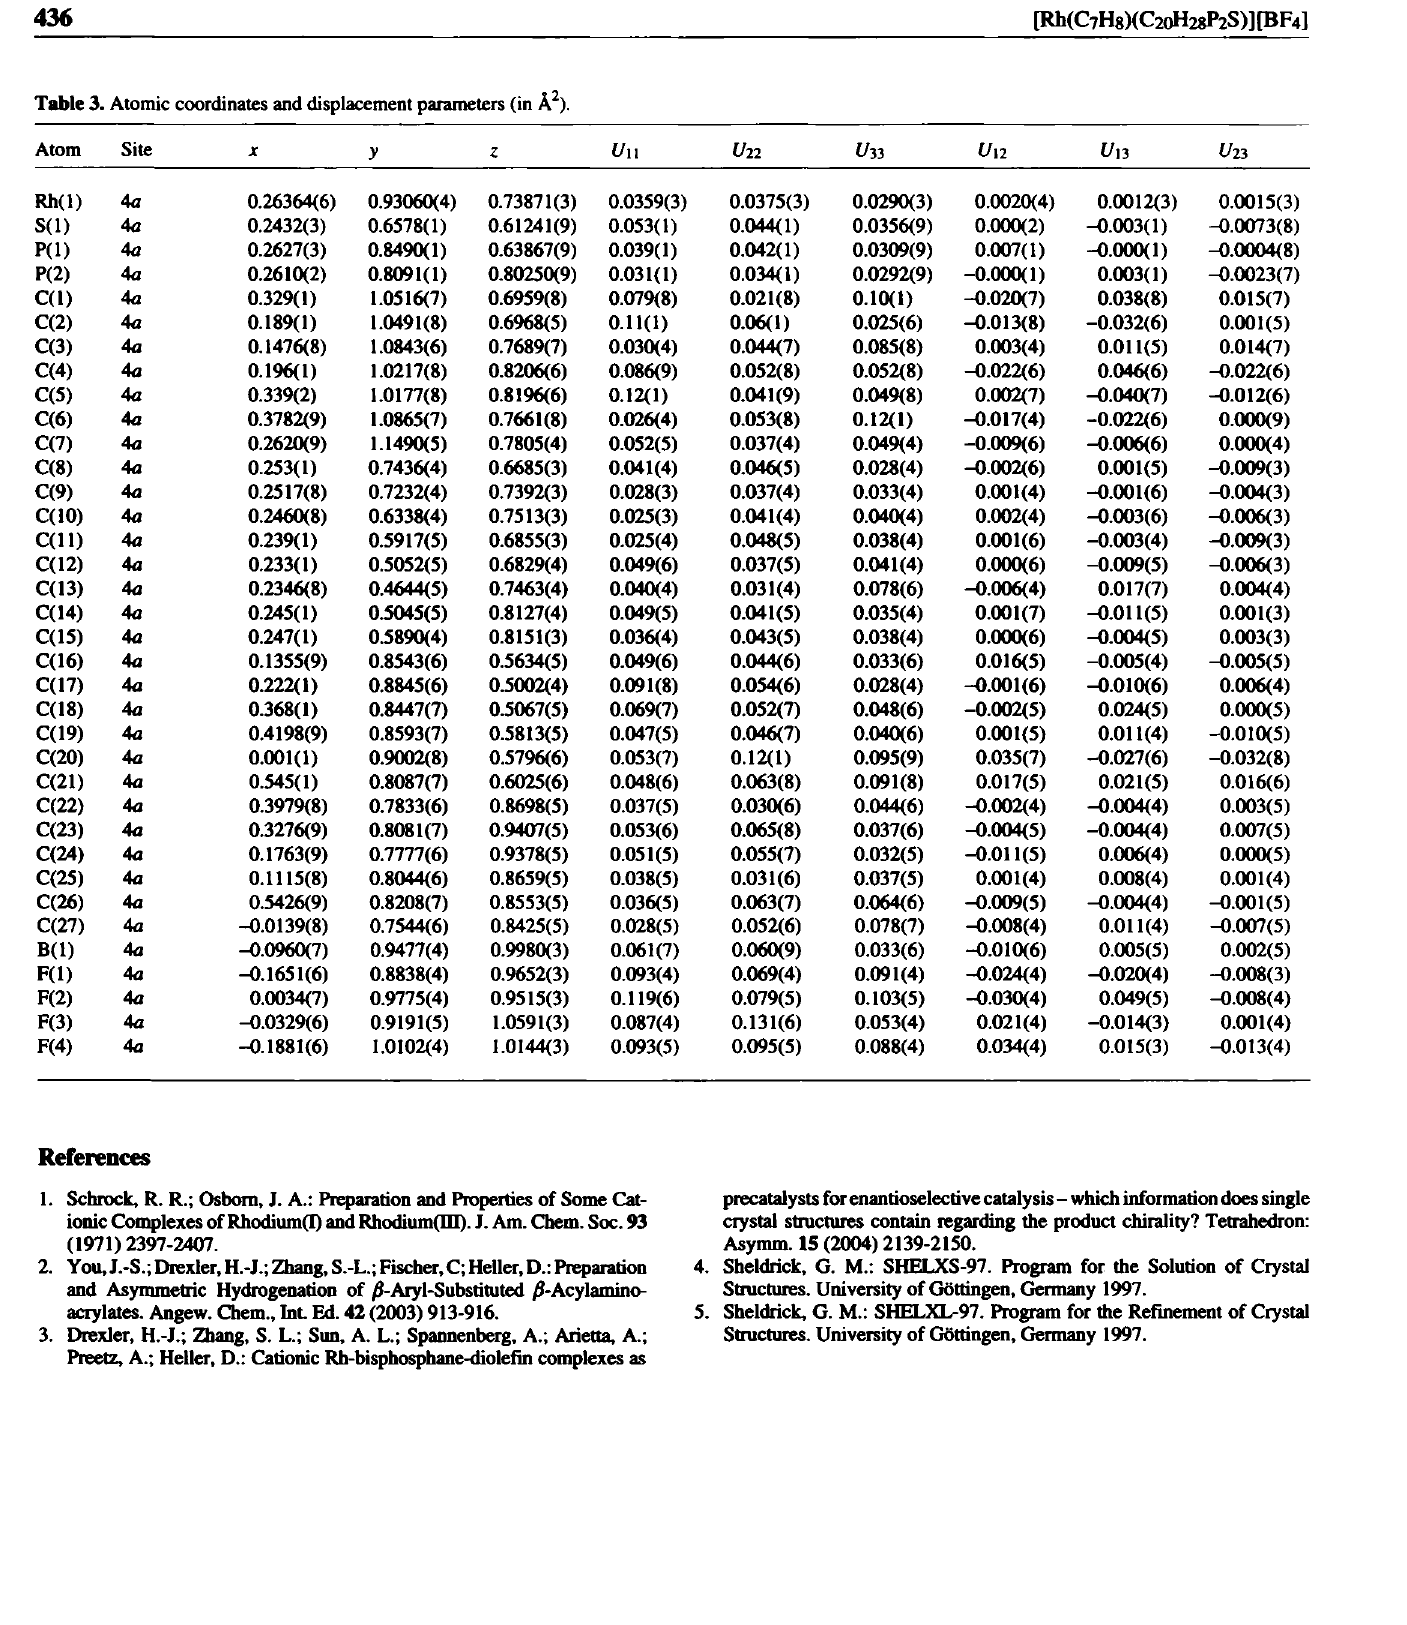
Table 3. Atomic coordinates and displacement parameters (in A 2